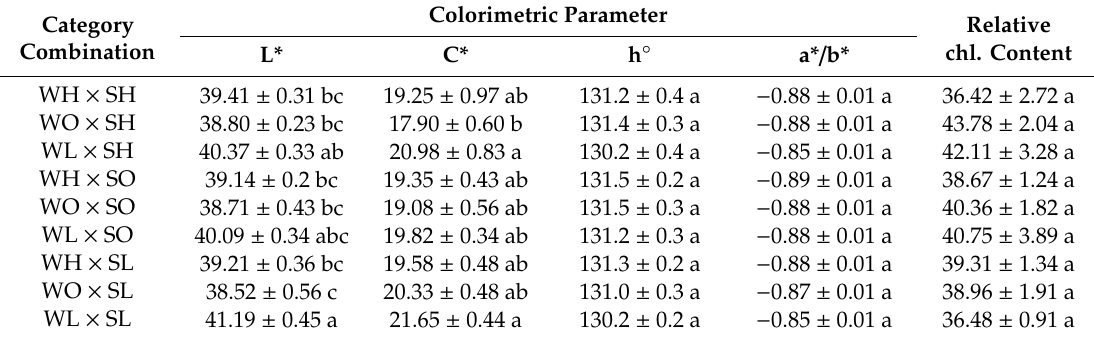
Table 2. Colorimetric parameters and relative chlorophyll content of grafted watermelon seedlings from nine quality category combinations obtained 7 days after grafting, as described in Table